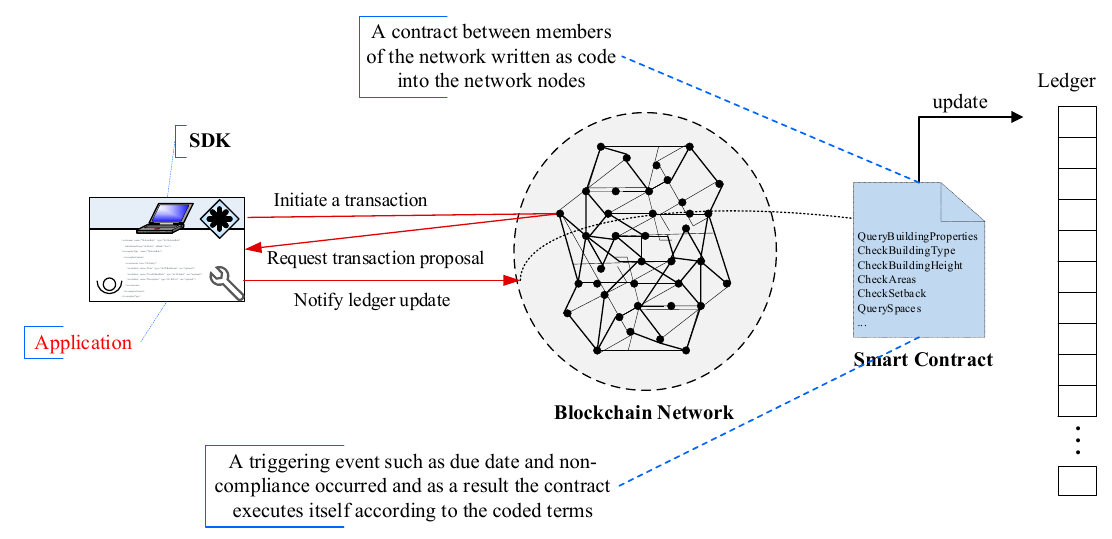
Figure 3. The concept of smart contract in a blockchain network.